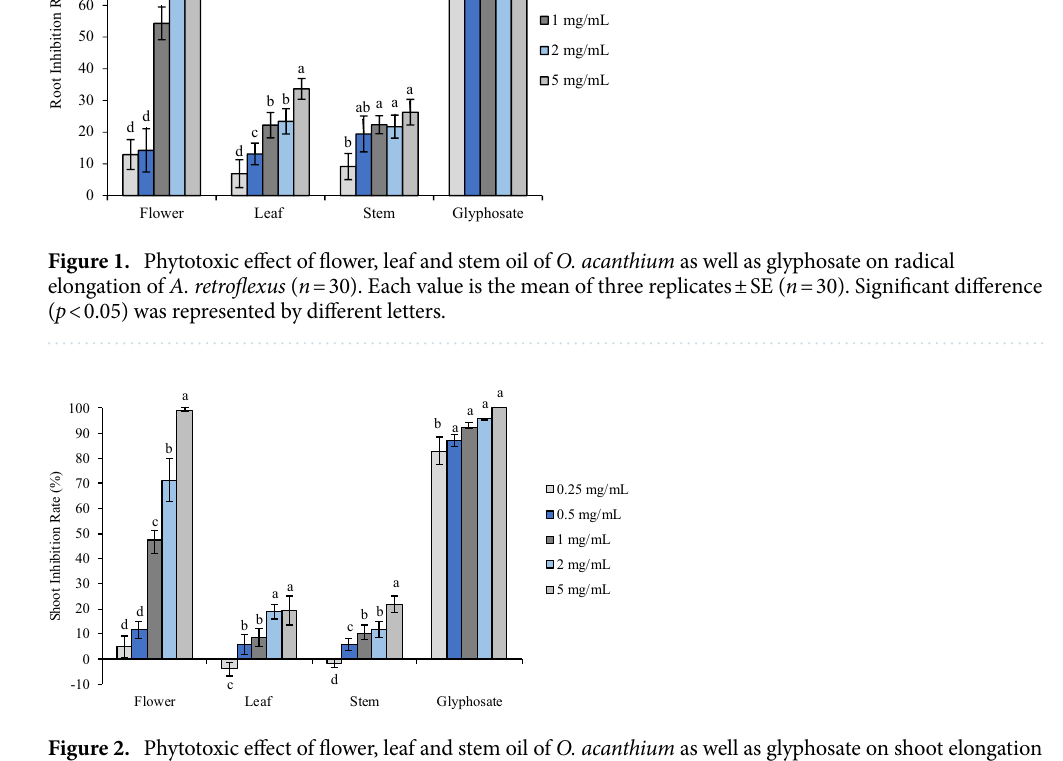
Figure 2. Phytotoxic effect of flower, leaf and stem oil of O. acanthium as well as glyphosate on shoot elongation of A. retroflexus. Each value is the mean of three replicates ± SE ( n = 30). Significant difference ( p < 0.05) was represented by different